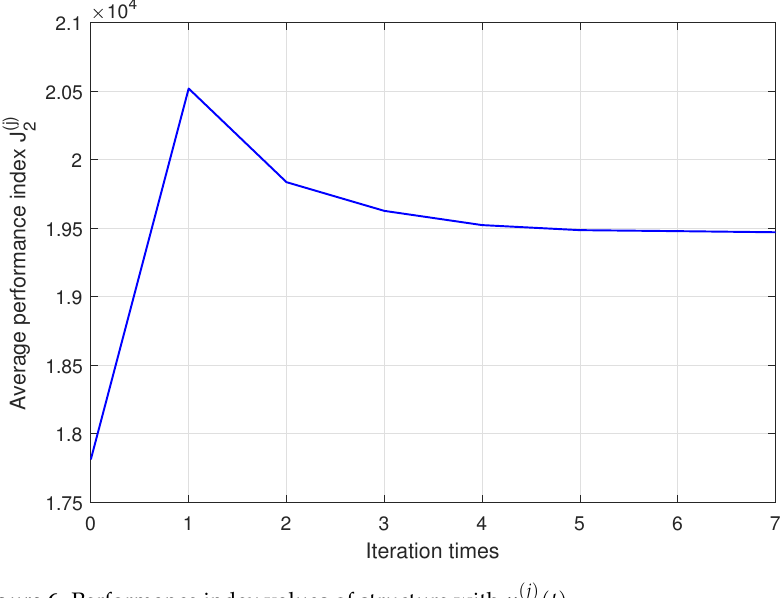
Figure 6. Performance index values of structure with u